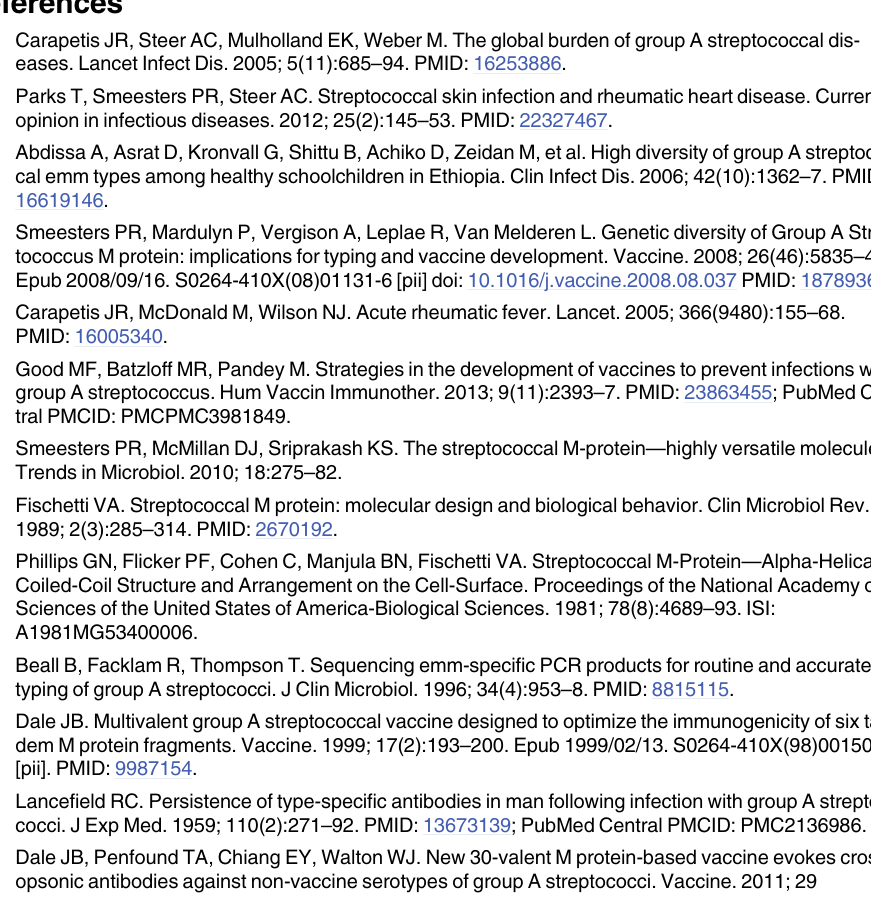
S1 Table. Distribution of J14